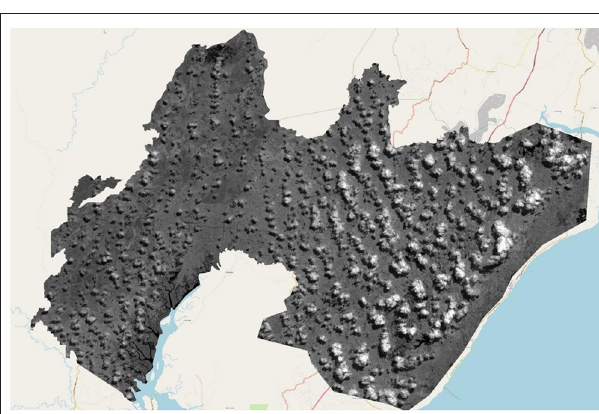
FIGURE 1 | Merged and clipped sentinel 2 image before